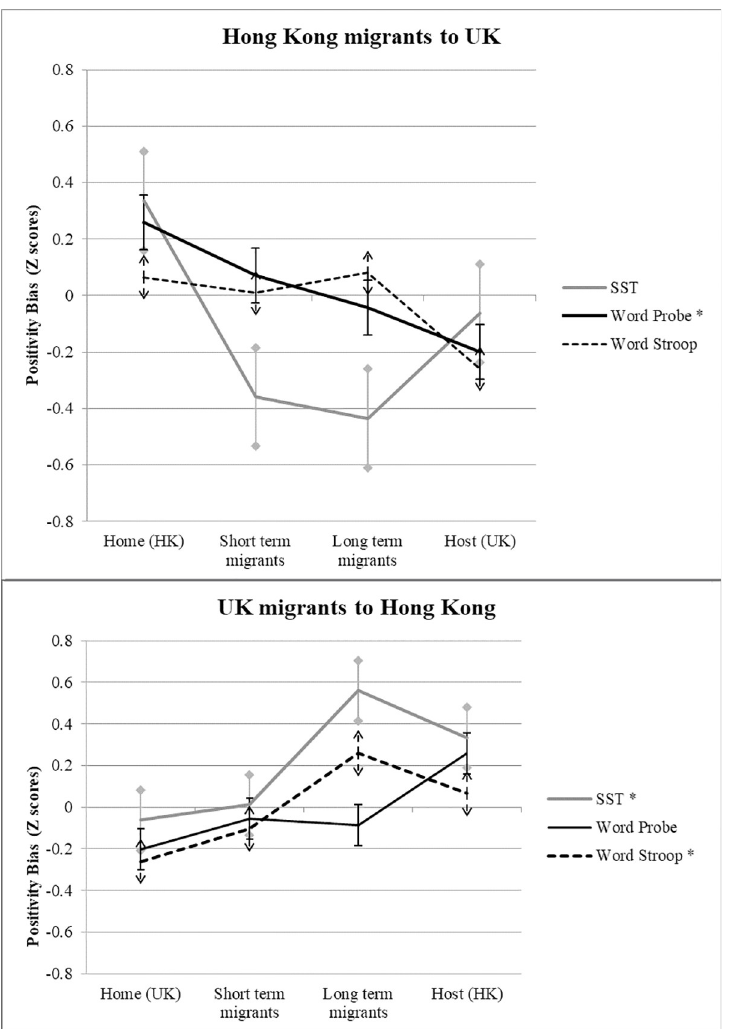
Fig 1. Pattern of acculturation effects across three measures of cognitive bias. (A) Hong Kong migrants to UK. (B) UK migrants to Hong Kong. Values are standardized values (Z scores) of the bias score means provided in Table 2, to allow meaningful comparison of the pattern of data across tasks with different dependent measures. Abbreviations: SST–scrambled sentences task. HK–Hong Kong. UK–United Kingdom. � indicates this task showed a significant linear trend at p <